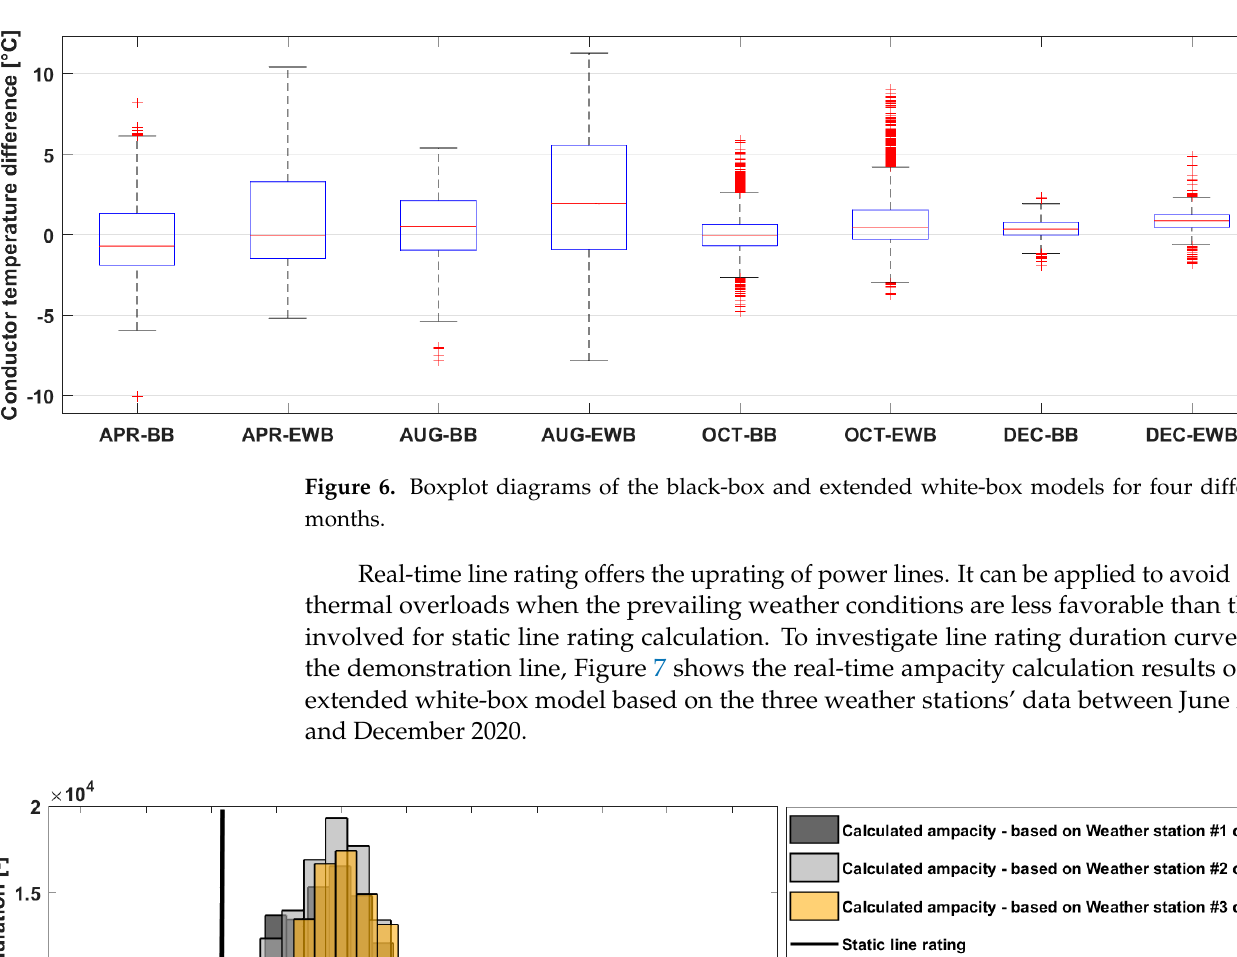
8 of 11 Figure 5. Performance analysis of the investigated models, April 2020: ( a ) Performance of the black- box model; ( b ) Performance of the extended white-box model; ( c ) Comparison of the black-box and extended white-box model results. Boxplot diagrams of the model calculations and the sensor measured values are pre- sented to get a complete view of the models’ performance. In Figure 6, the statistical anal- ysis is presented regarding the developed model for four months to eliminate the seasonal trends. The boxplots demonstrate that, for colder periods such as December and October, the performance of the black-box and extended white-box are close to each other. How- ever, it is essential to note that, in these periods, the outliers are more significant in the